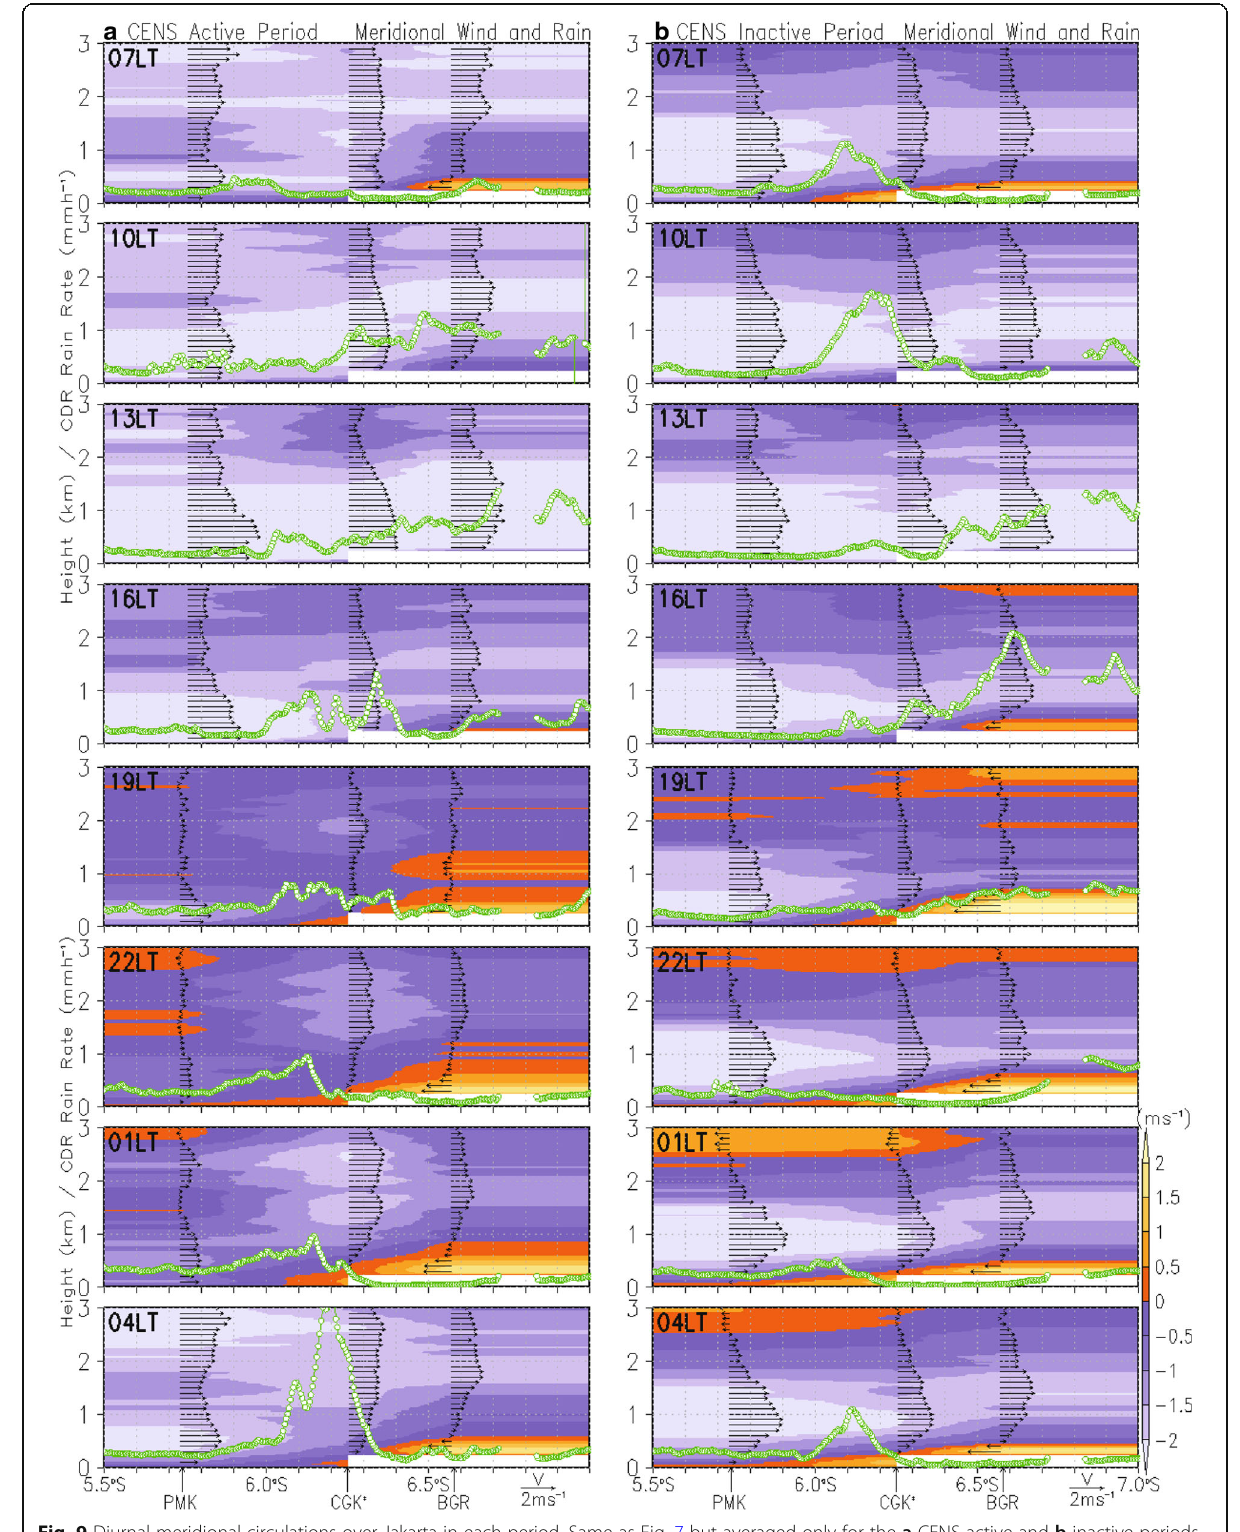
Fig. 9 Diurnal meridional circulations over Jakarta in each period. Same as Fig. 7 but averaged only for the a CENS active and b inactive